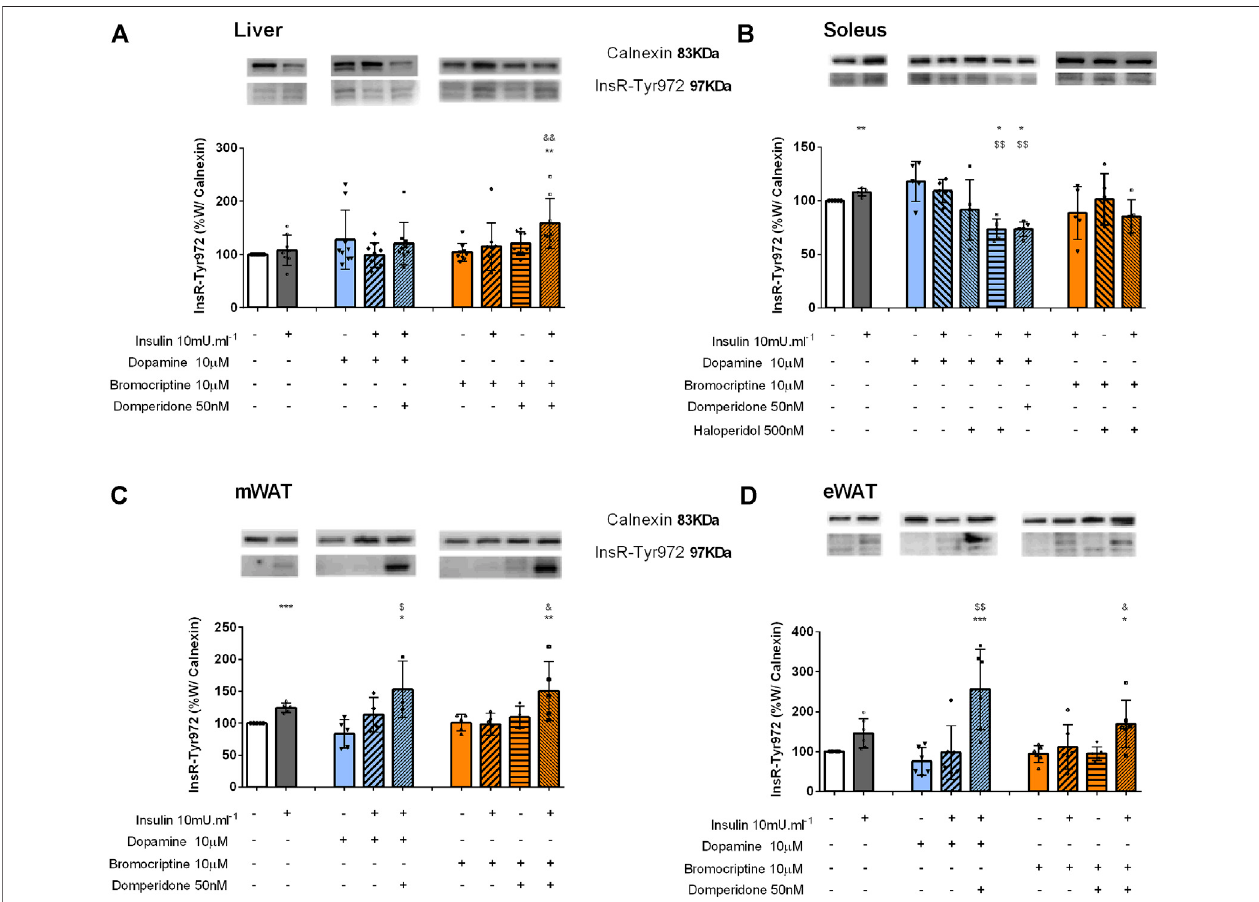
FIGURE 4 | Effect of dopamine and bromocriptine on insulin receptor phosphorylation in the liver (A) , soleus muscle (B) , mWAT (C) , and eWAT (D) . Effect of dopamine (10 μ M, blue bars) and bromocriptine, a D2R agonist (10 μ M, orange bars), on insulin receptor phosphorylation (InsR) in the presence and absence of insulin (10m U ml − 1 ) and its blockade by domperidone, a D2R antagonist (50 nM) and/or haloperidol (500 nM), a D1R and D2R antagonist in the liver, the soleus muscle, mWAT, and eWAT. The top of the fi gures show representative Western blots for the effect of dopamine and bromocriptine on InsR-Tyr972 (97 kDa band) phosphorylation, in the presence and absence of insulin and its blockade by domperidone and/or haloperidol. Calnexin was used as the loading control (83 kDa band). Bars represent mean ± SD of the expression of InsR-Tyr972. On the bottom of the bars are shown the different conditions used for each group tested with + meaning presence of that stimuli and – absence of it. One-way ANOVA with Dunnet ’ s post hoc comparison test * vs control; # vs . insulin; $ vs . dopamine; & vs . bromocriptine. Levels of signi fi cance: * p < 0.05; ** p < 0.01; *** p < 0.001; **** p < 0.0001. mWAT, mesenteric white adipose tissue; eWAT, epididymal white adipose tissue; D1R, dopamine receptor type 1; and D2R, dopamine receptor type